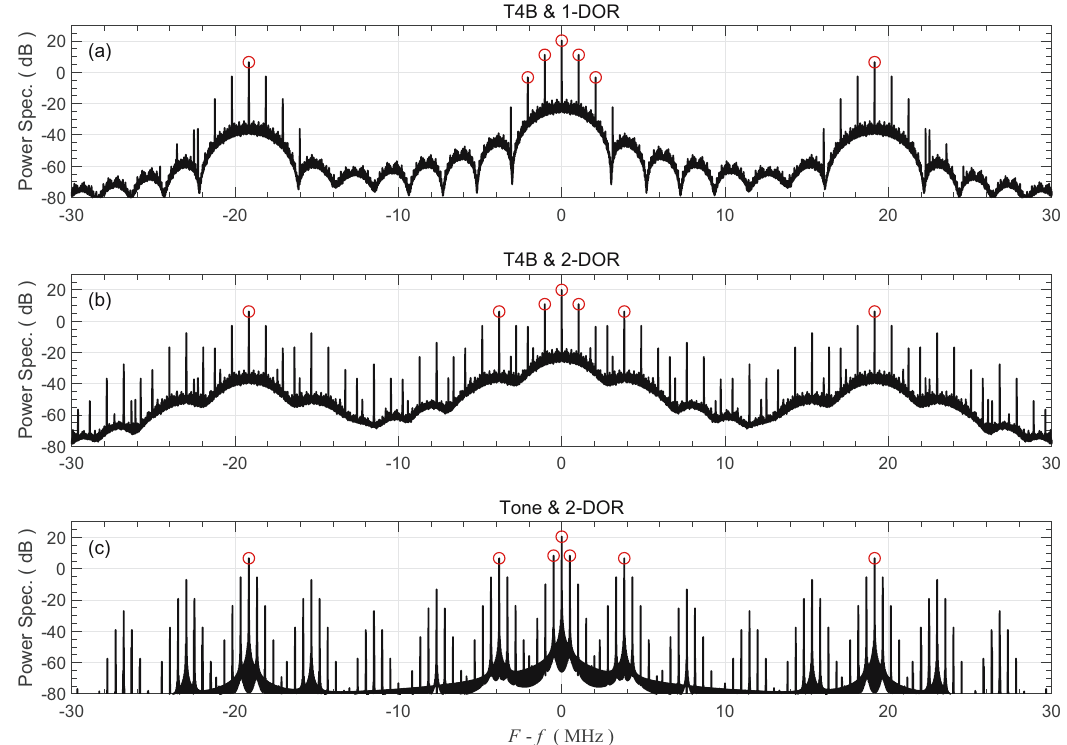
Figure 3: Power spectra of the novel ( a ) , normal ( b ) , and classic ( c )